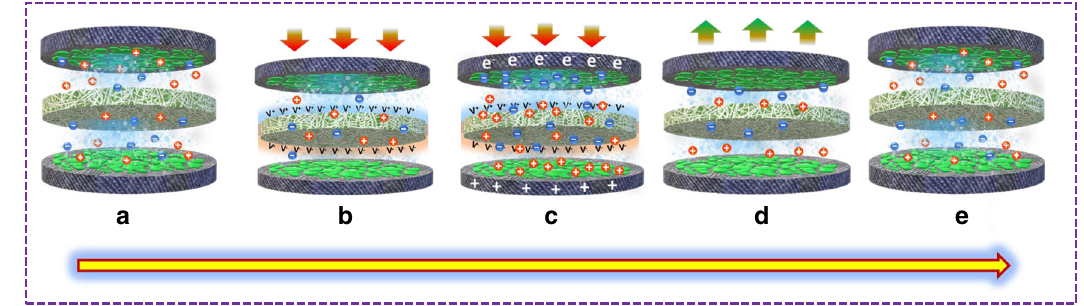
Fig. 7 Schematic illustration of the working mechanism of the siloxene SCSPC device. a The initial state of the siloxene SCSPC device with no applied compressive force. b With an applied compressive force to the siloxene SCSPC device, the siloxene/PVDF creates a piezoelectric potential that drives the electrolyte ions towards the electrode surface. c An equilibrium state has been reached between the piezoelectric potential created and the electrochemical reaction of the siloxene SCSPC device. d State of siloxene SCSPC when the compressive force is stopped, i.e., the disappearance of piezoelectric potential and leads to attaining the equilibrium state. e State of siloxene SCSPC after completion of one self-charging